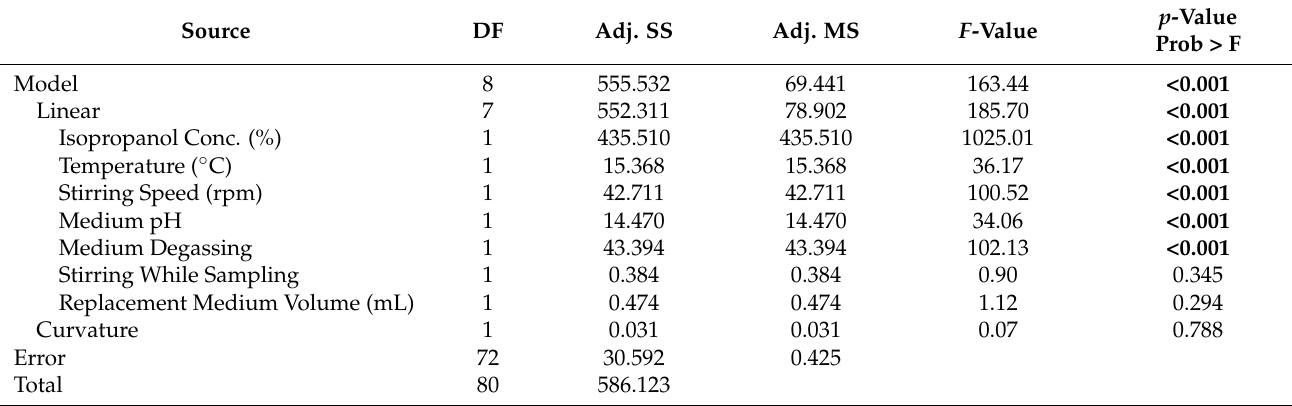
Table 3. Summary of analysis of variance (ANOVA) of Plackett–Burman screening design batches for ETF/DEA flux ratios.